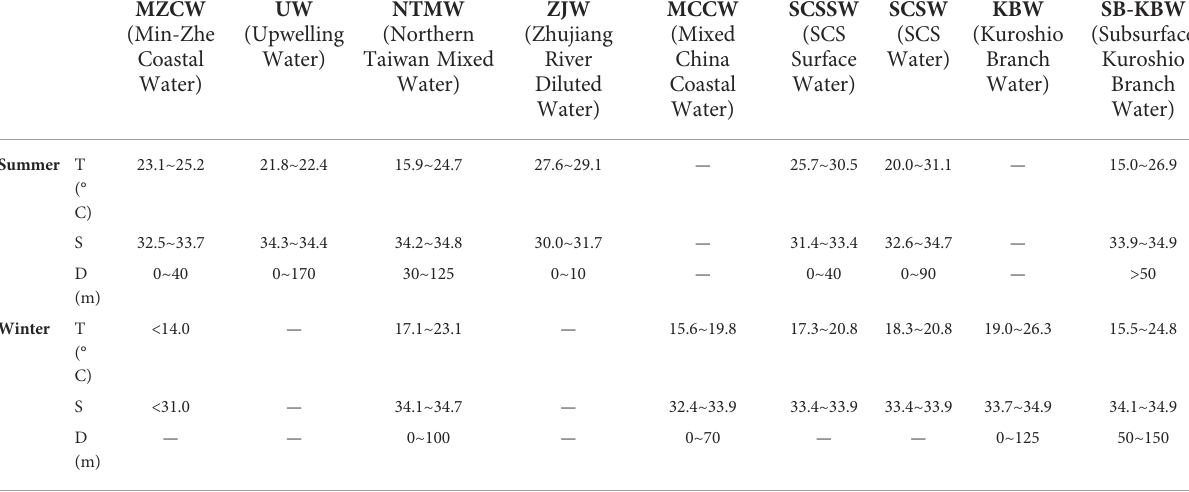
TABLE 3 Ranges of temperature, salinity, depth range of water masses in the Taiwan Strait in summer and